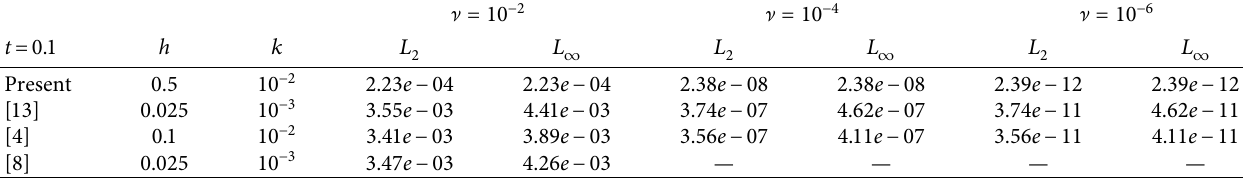
Table 3: Solution of the equation at time t � 0.1 for the second test problem.